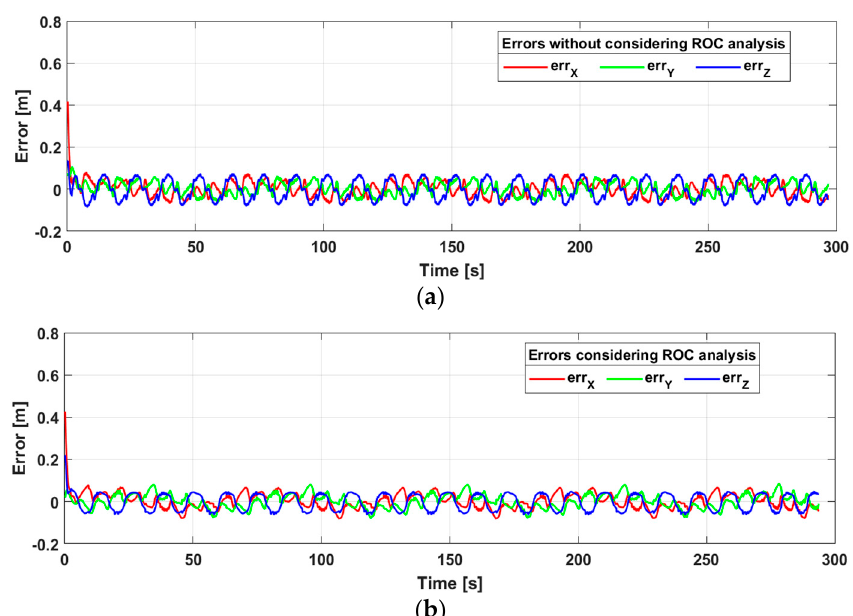
Figure 16. Errors in each of the axes of the second experiment: ( a ) without considering ROC analysis and ( b ) considering ROC analysis.